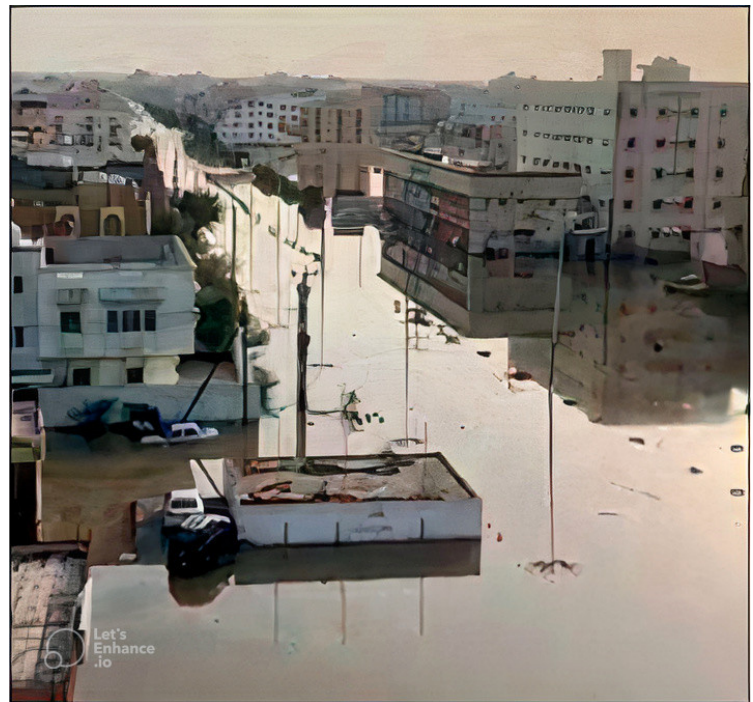
Figure 1. Floods in Al-Lith City on 25 November 2018 [27].